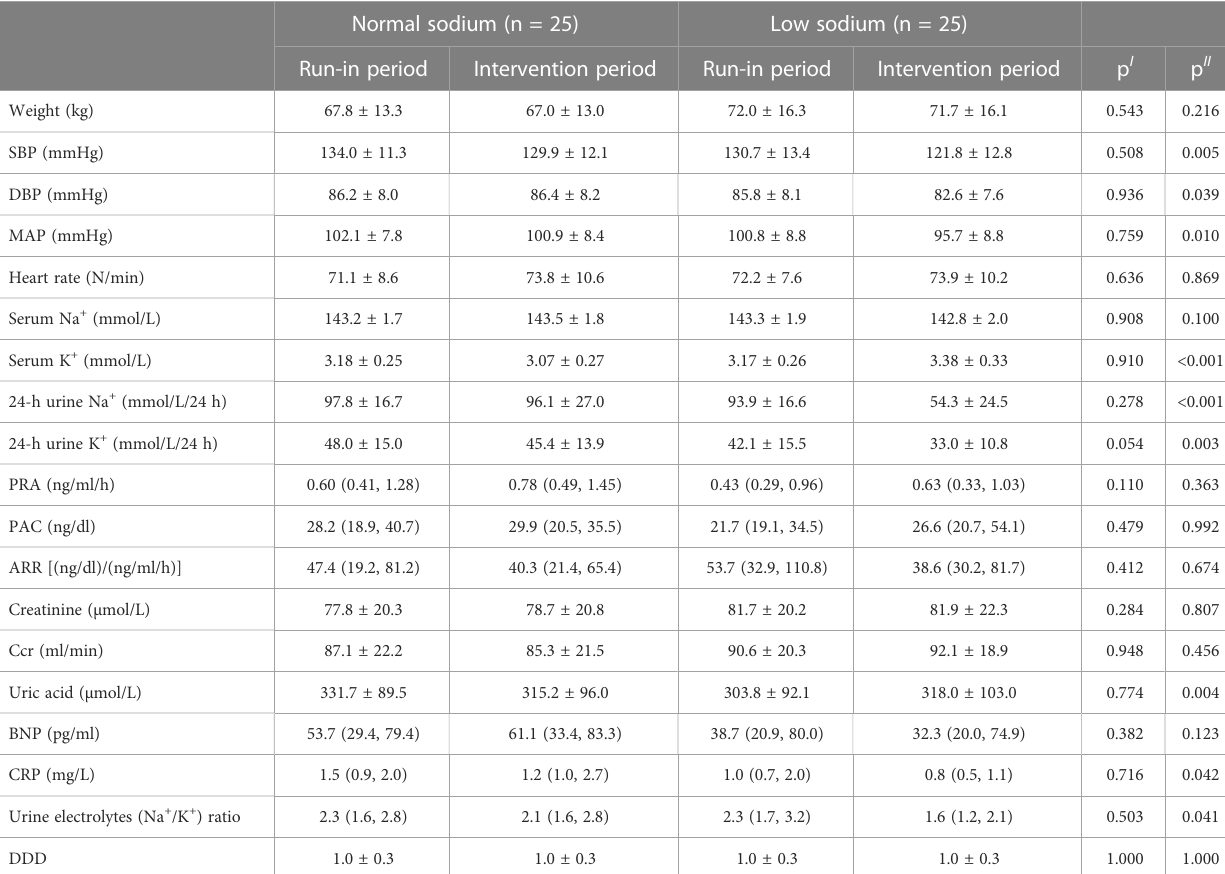
TABLE 2 Results of the dietary